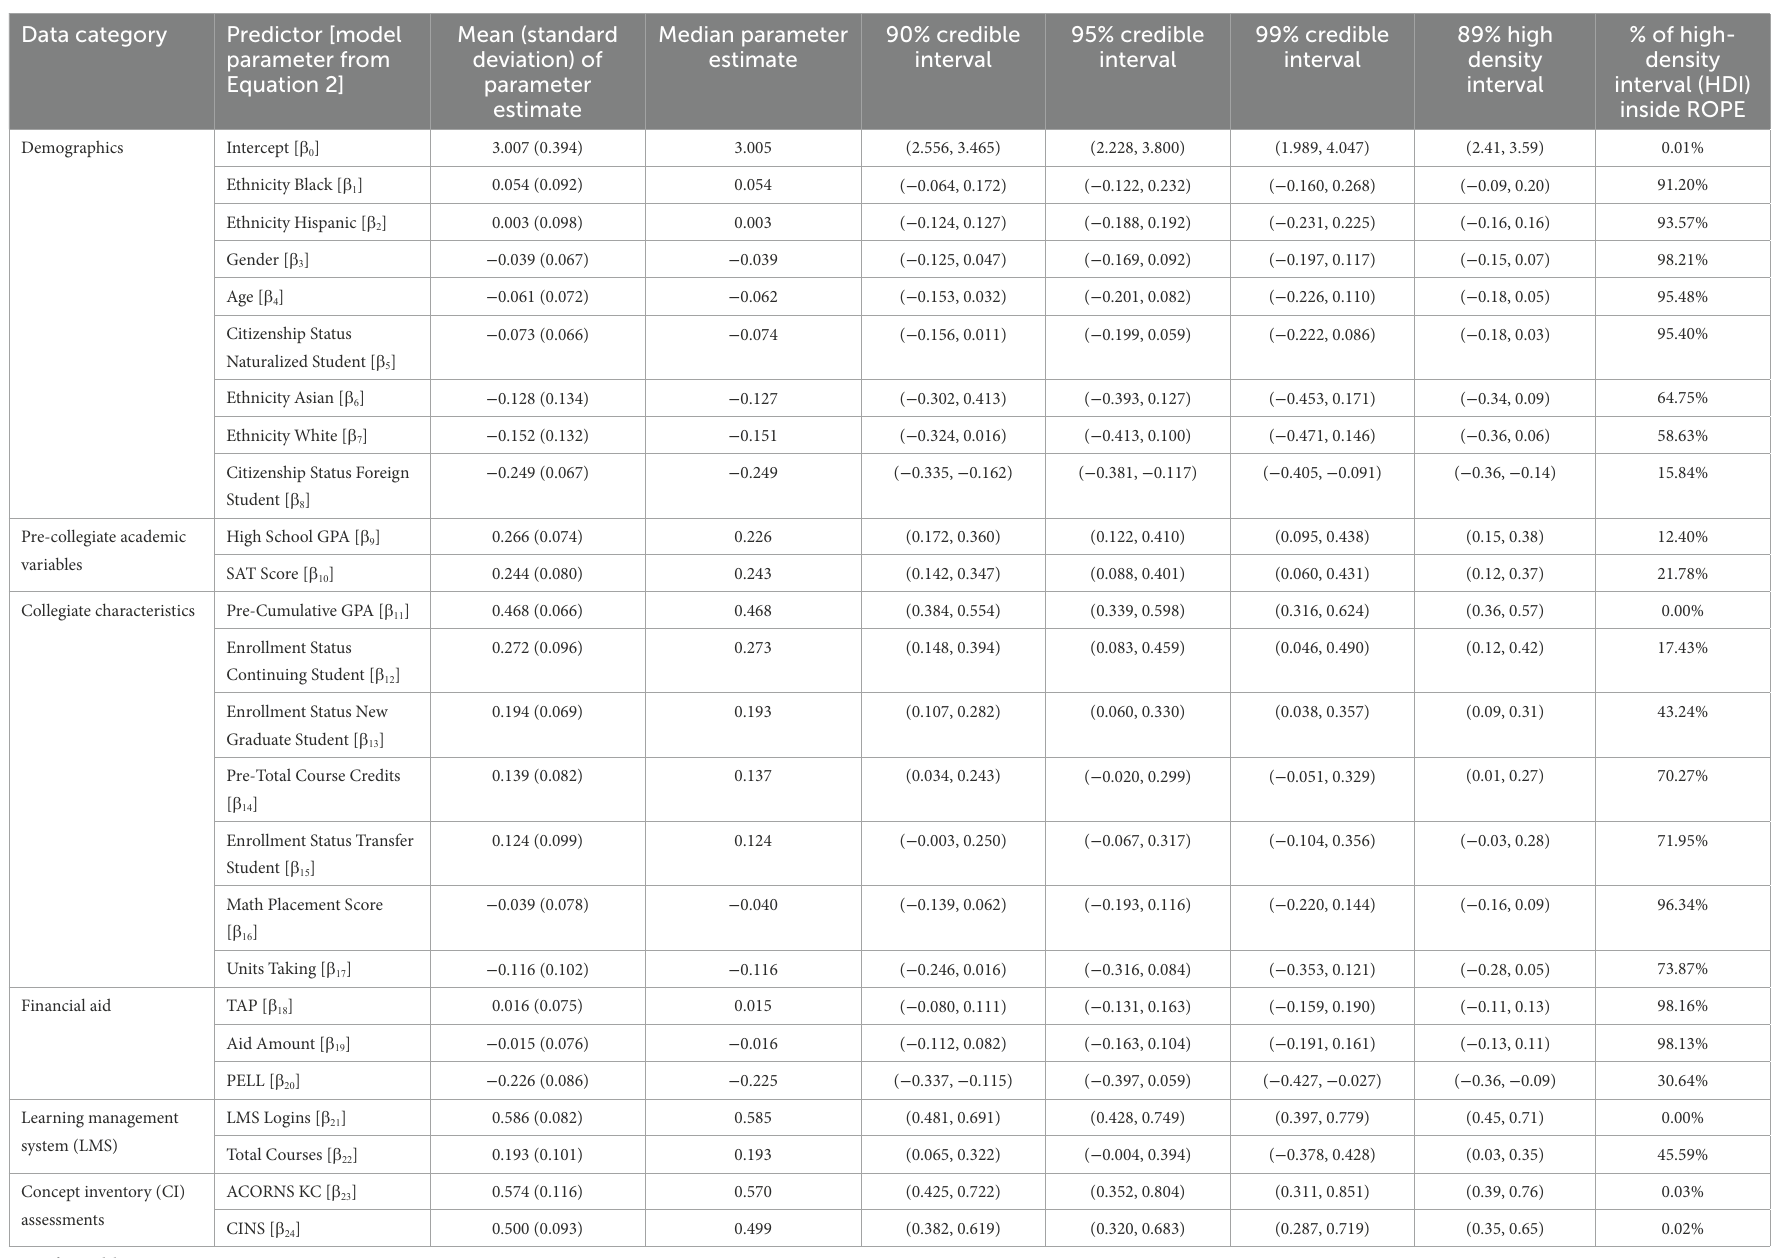
TABLE 3 Logistic regression parameter estimates, credible intervals, 89% high density interval, and ROPE overlap percentage